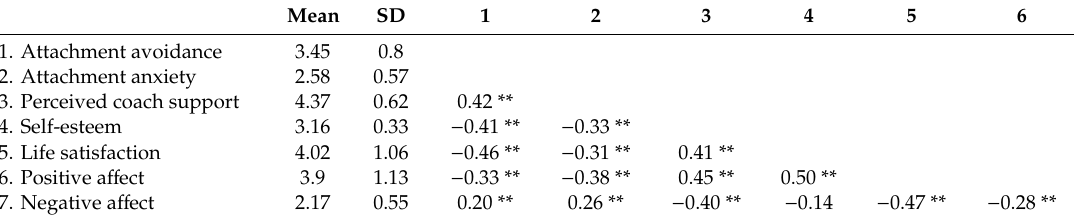
Table 1. Descriptive statistics and correlation analysis of all the variable ( n = 177).